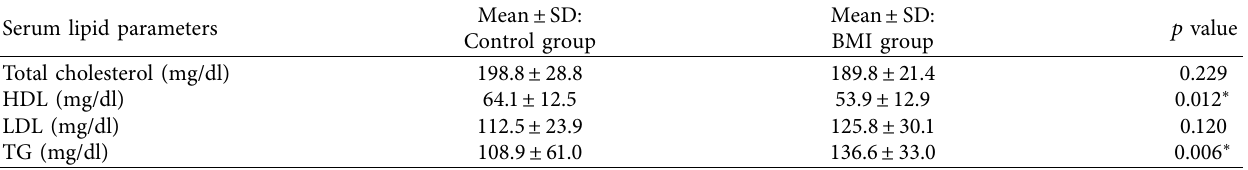
Table 3: The results of the serum lipid parameters in both groups ( n � 47) after Bonferroni correction (adjusted p value � 0.0125). Mean ± SD: Serum lipid parameters